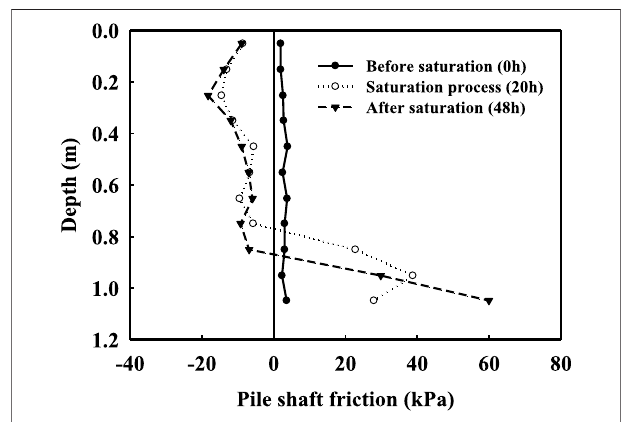
FIGURE 15 | Variations of pile shaft friction distribution of